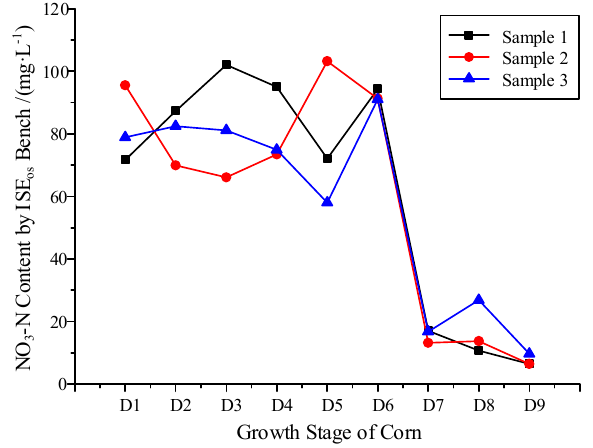
− -N Variation by the On-site detection Figure 4. Monitoring of NO 3 − ‐ N Variation by the On ‐ site detection Bench. Figure 4. Monitoring of NO 3